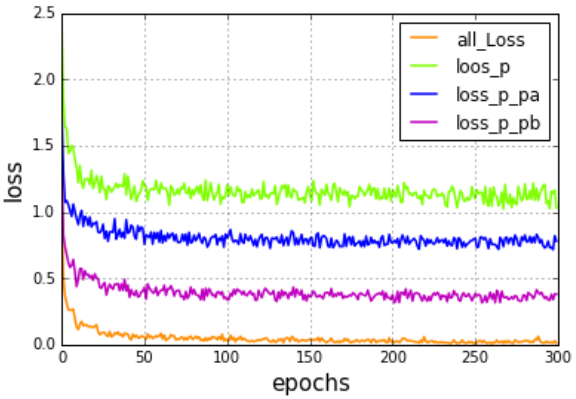
Figure 10. Loss values of the different loss function.